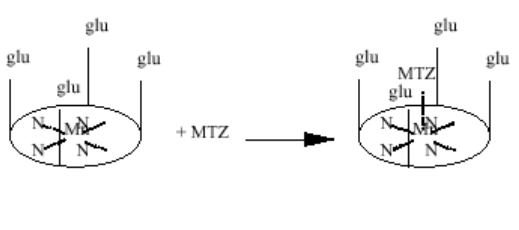
Figure 3. Skeleton of the interaction of MTZ with MnT( o -glu)TTCl.